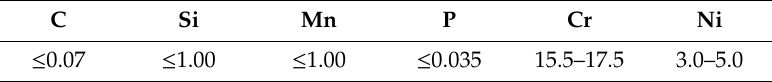
Table 2. Main chemical contents of 17-4PH stainless steel (wt.%).